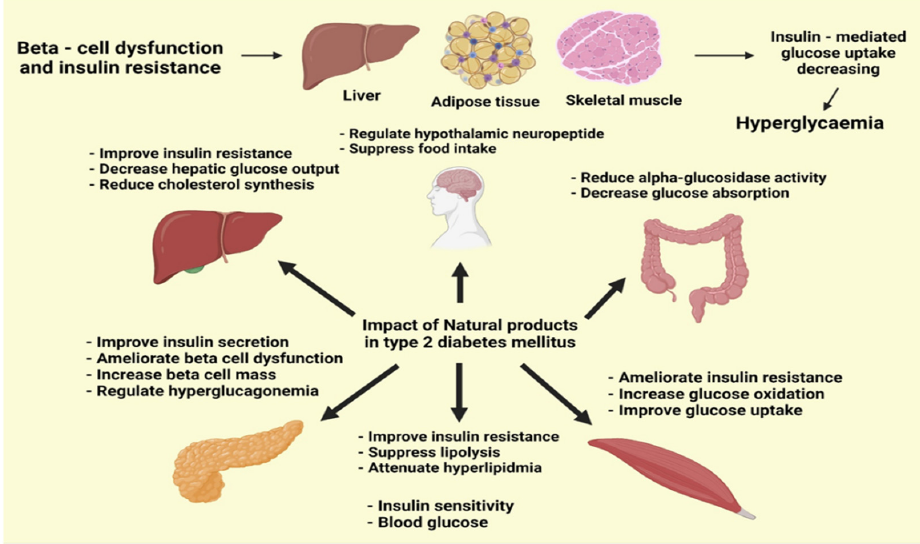
Figure 2. Natural products in type 2 diabetes mellitus.